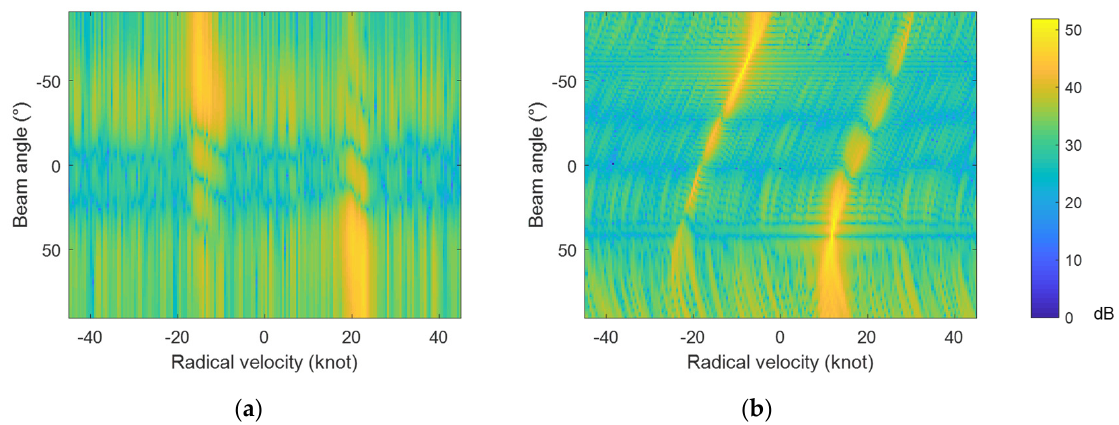
Figure 15. Space–time two-dimensional spectrum before and after motion compensation for the case of uniform yaw motion when ship velocity is 10 knots: ( a ) results before motion compensation, ( b ) results after motion compensation.